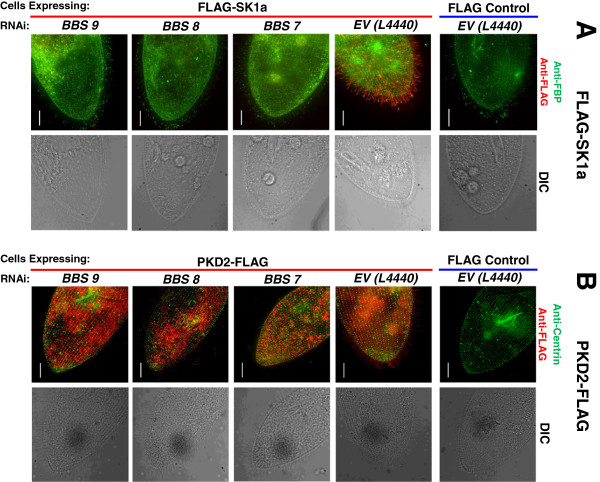
Immunofluorescence of FLAG-SK1a channels or PKD2-FLAG channels in BBS7 - or BBS8 - or BBS9-depleted cells). (A) FLAG-SK1a channels. (B) PKD2-FLAG channels. FLAG-SK1a- expressing cells were stained with anti-FLAG antibody and as a contrast, anti-folate chemoreceptor (FBP) antibody in a series of control and RNAi conditions. Only the merged images are shown here. Complete immunofluorescence of the folate chemoreceptor and the FLAG-SK1a channel are shown separately in Additional file 9: Figure S5. The FLAG control is a cell microinjected with FLAG-pPXV vector and fed with RNAi empty vector (L4440) bacteria. The FLAG-SK1a control is a cell expressing FLAG-SK1a and fed bacteria with an RNAi empty vector (L4440). BBS7, BBS8 and BBS9 are the cells expressing FLAG-SK1a channel and also BBS7-, BBS8- or BBS9-depleted, respectively. Cells were immunostained with anti-FLAG (red) and anti-FBP (green) antibodies. Differential interference contrast (DIC) images are shown to document that cilia are present. Cells expressing PKD2-FLAG channel (B) were stained with anti-FLAG antibody (red) and anti-Tetrahymena centrin-1 antibody (green) in a series of control and RNAi conditions. Only the merged images are shown here; the staining of FLAG and centrin can be seen separately in Additional file 10: Figure S6. The FLAG control is a cell expressing the FLAG-pPXV vector and fed with RNAi empty vector (L4440) bacteria. The PKD2-FLAG control is a cell expressing the PKD2-FLAG channel and fed with bacteria with RNAi empty vector (L4440). BBS7, BBS8 and BBS9 are the cells expressing the PKD2-FLAG channel and are BBS7-, BBS8- or BBS9- depleted, respectively. Differential interference contrast (DIC) images are shown to document that cilia are present. All images were taken under 60× oil immersion objectives. Scales represent 15 μm. Images are representative of results of three experiments, n = 126 to 156 cells.